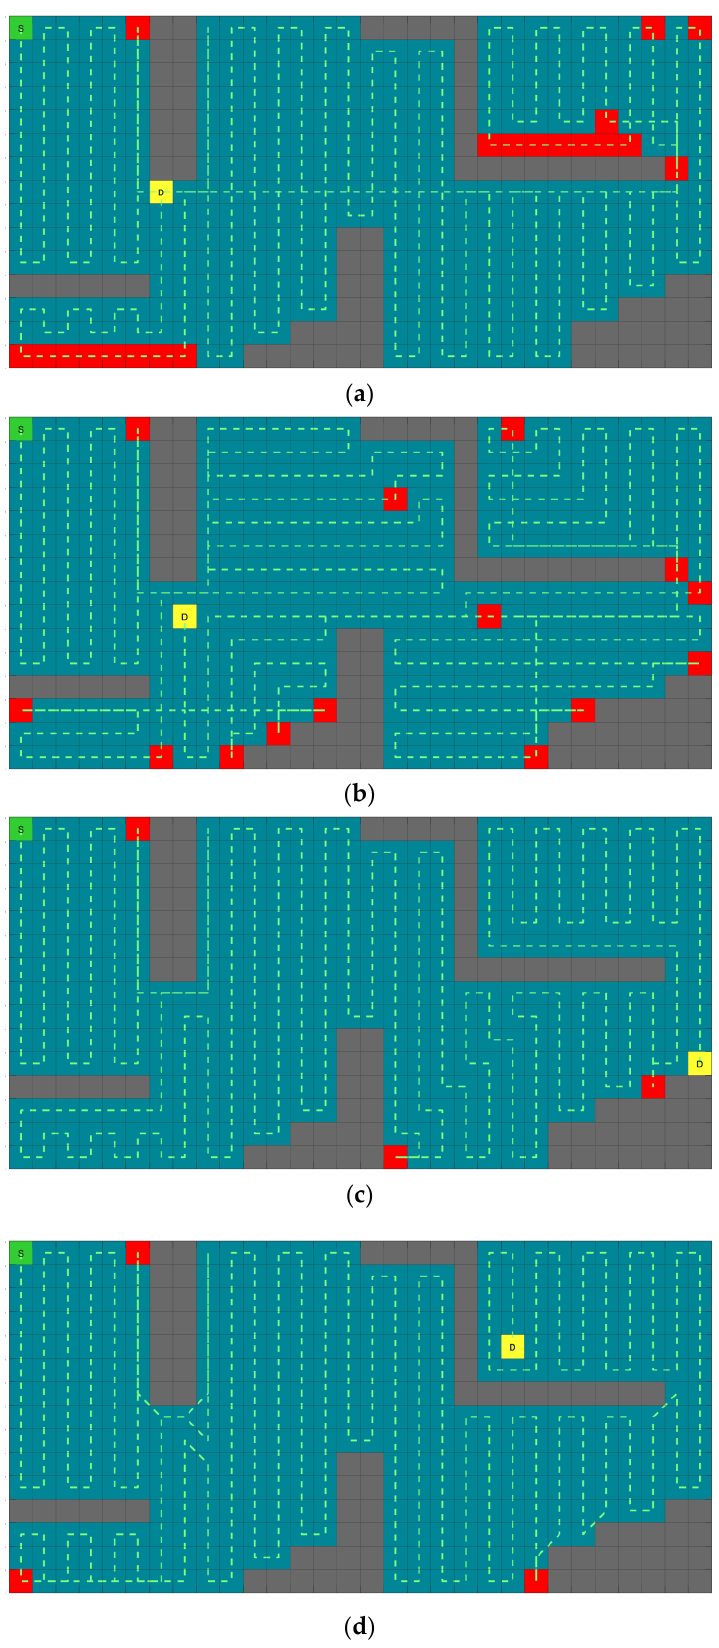
Figure 12. Generated path of different algorithms in the artificial environment: ( a ) Boustrophedon cellular algorithm. ( b ) BINN algorithm. ( c ) Improved BINN algorithm. ( d ) CCNN algorithm.